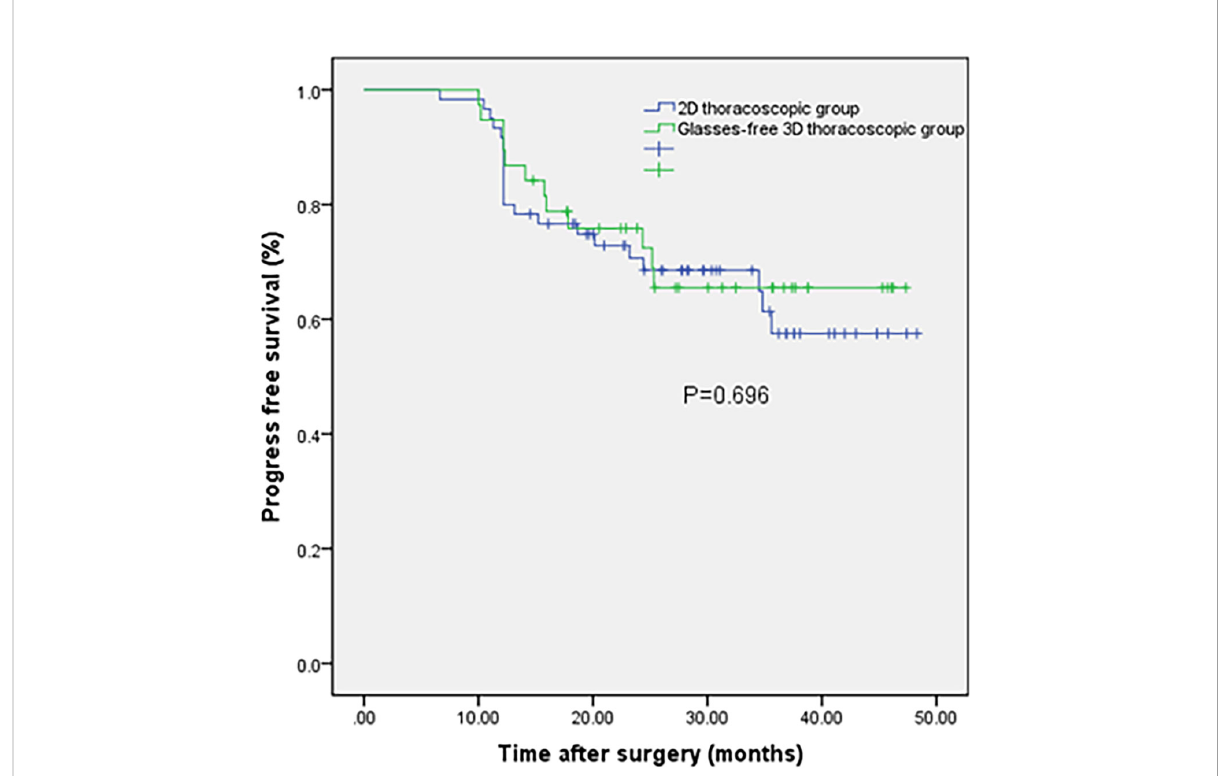
FIGURE 2 Kaplan – Meier curves for the glasses-free three-dimensional thoracoscopic group and two-dimensional thoracoscopic group.